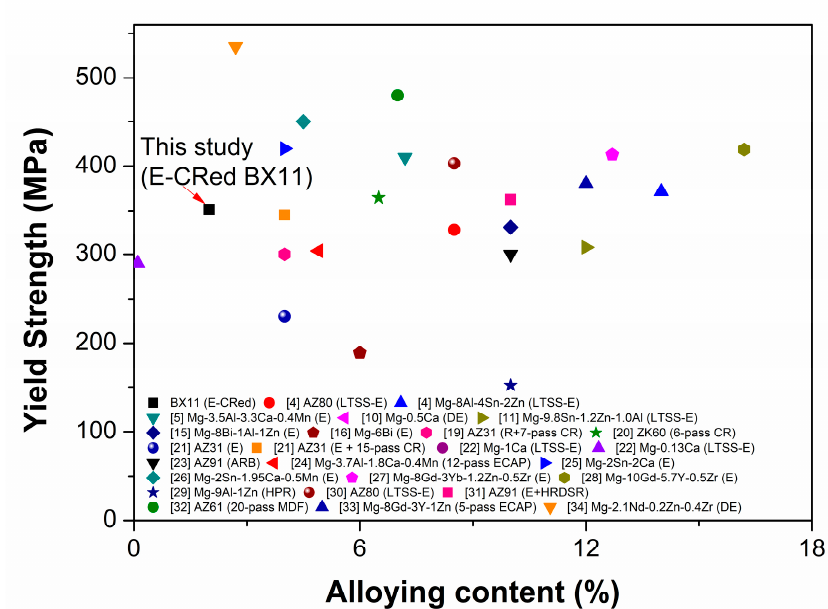
Figure 8. Comparison of YS vs. alloying content of E-CRed BX11 alloy with reported various wrought Mg alloys [4,5,10,11,15,16,19,21–34].